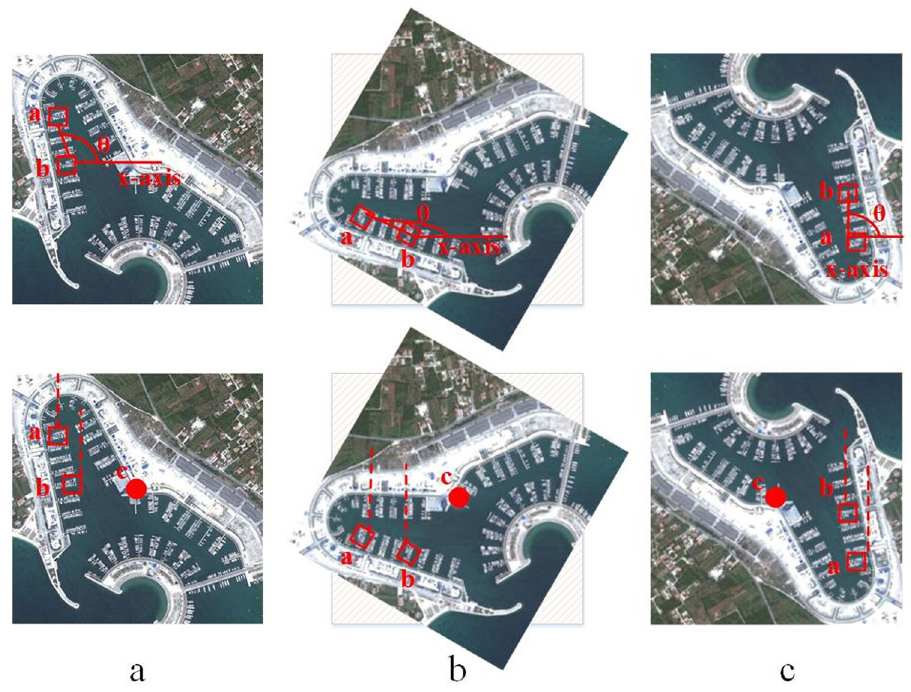
Fig 2. PIWAH [24] and POVH image representation (a) original image (b) image transformed by 60˚ rotation (c) image transformed by 180˚